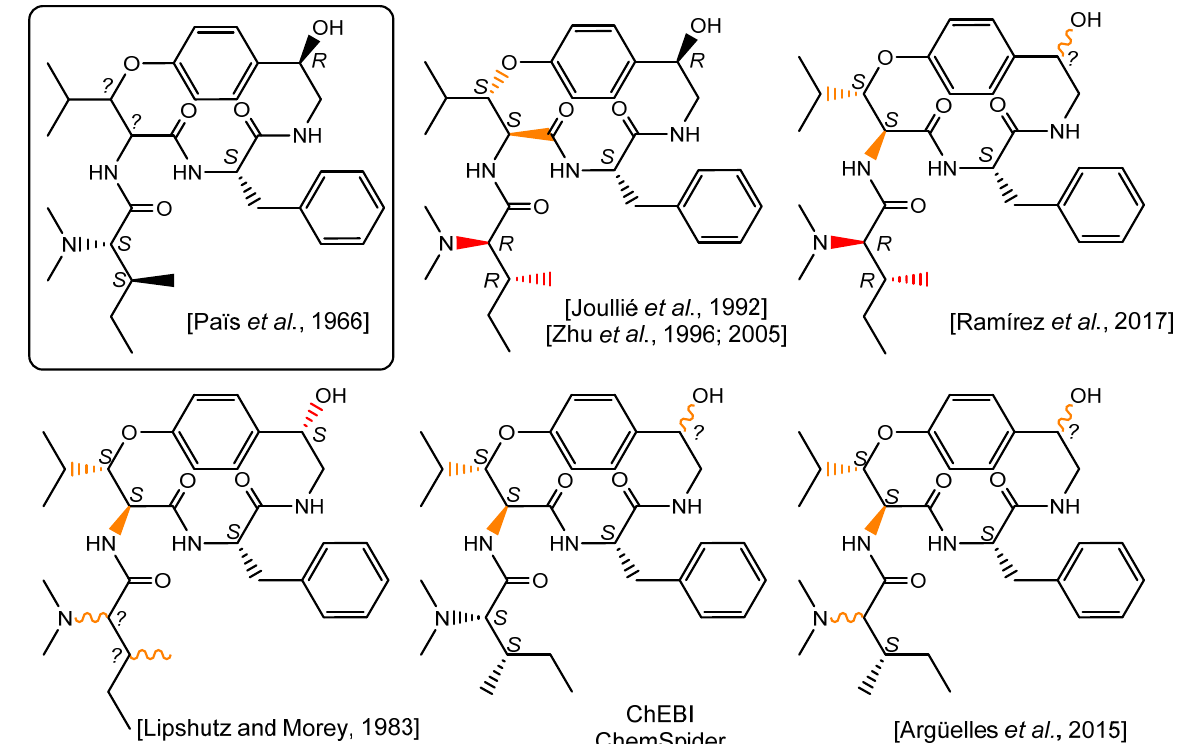
Figure 2. Chemical structure of pandamine as seminally elucidated in 1966 and a selection of later chemical depictions. Bonds appearing in red are inconsistent with some of the deductions made in the original structure elucidation report. Bonds appearing in orange do not find spectroscopic support OR do not take into account previously determined stereochemical assignments for wavy bonds. [2,7–9,15,16].